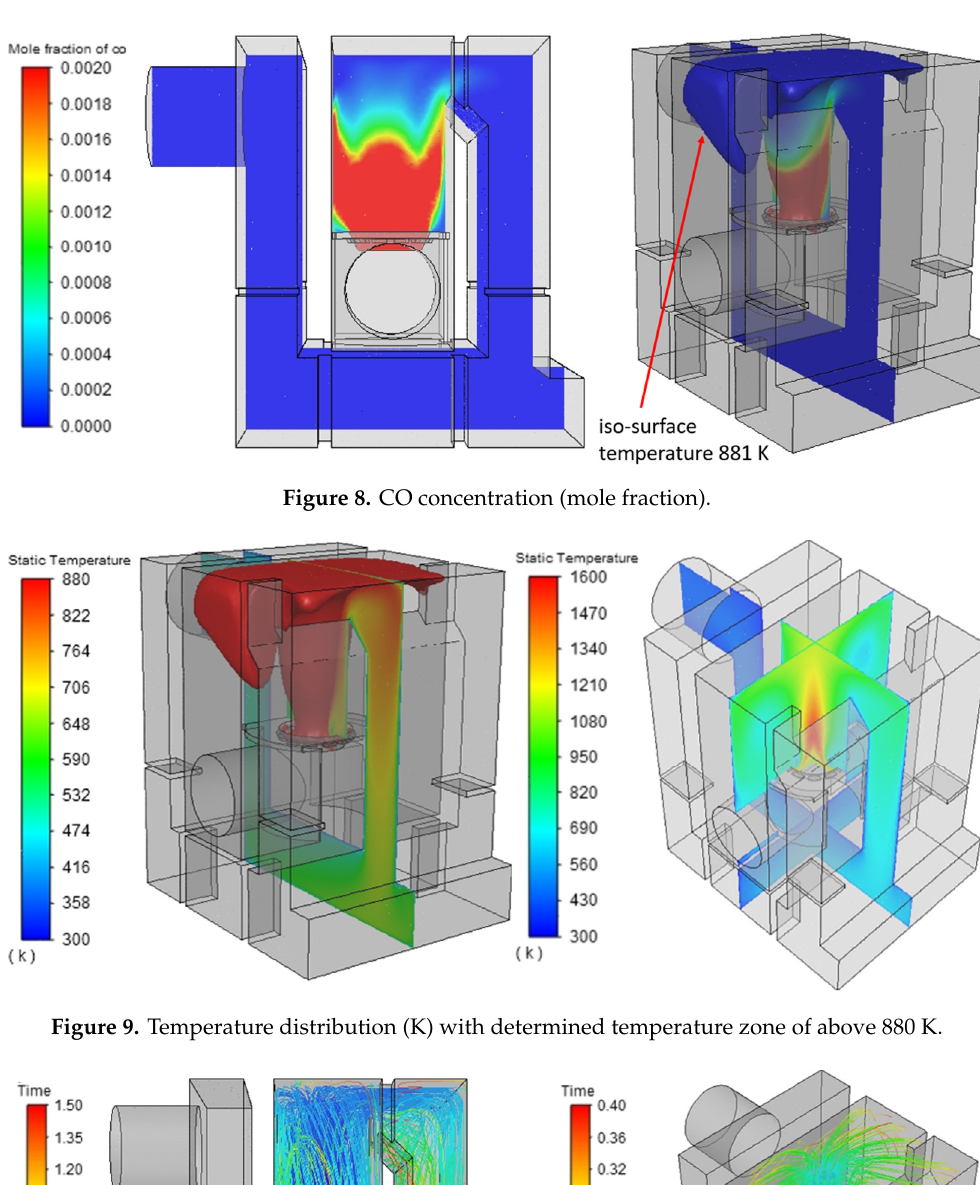
Figure 7. Gas particle paths—temperature scale (K).